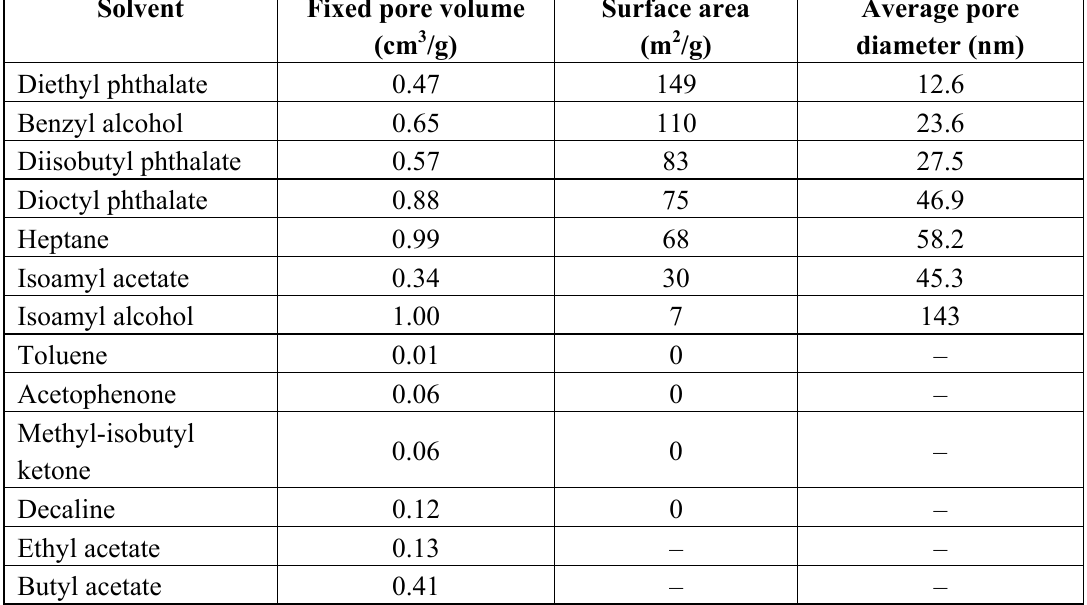
Table 4. Porosity properties of styrene- co -divinylbenzene synthesized with different porogenic solvents. The parameters are obtained from nitrogen porosimetry (Data obtained from